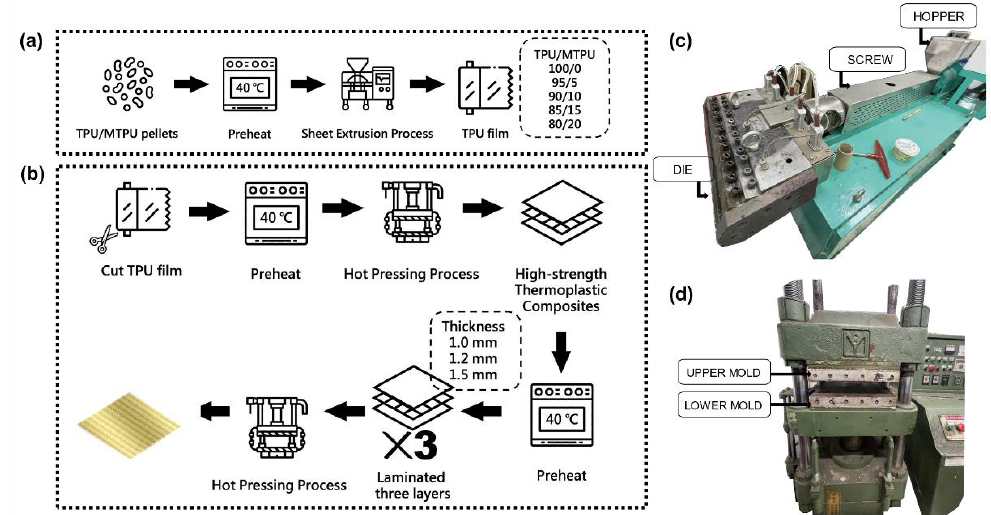
Figure 1. Process diagrams of ( a ) TPU planks and ( b ) Kevlar/TPU laminated composites. Images of ( c ) film extrusion assembly and ( d ) hot pressing assembly.